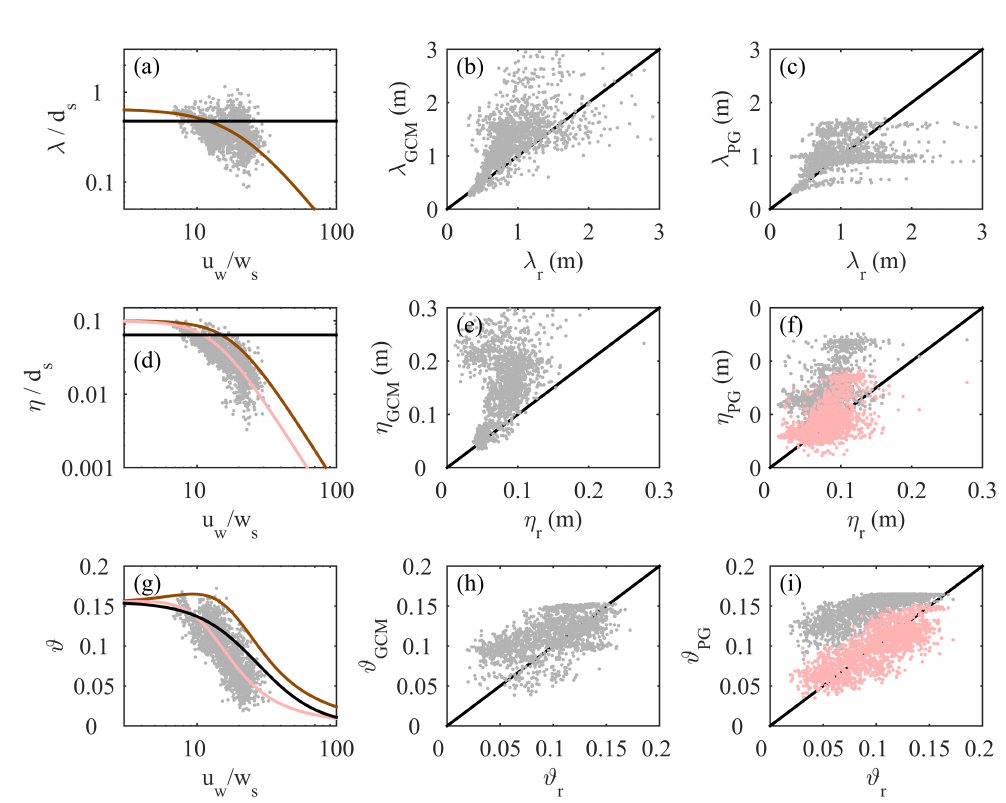
/d /d , ( d ) normalized ripple height η r s r s versus the ratio of the peak semi-orbital velocity u over the r w (gray dots). The black and brown lines in ( a ), ( e ) and ( g ) are the s = 8 s was used to relate u to d in the GCM p w s predictor, see text for further s